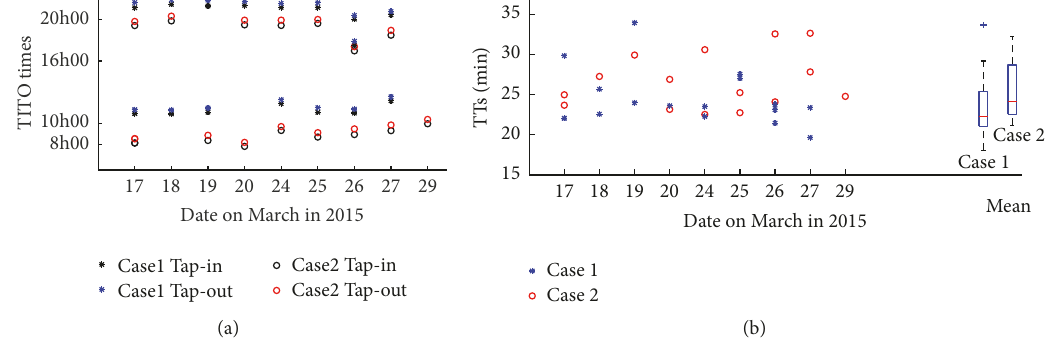
Figure 5: Trips made by the busiest passenger during nine days in March